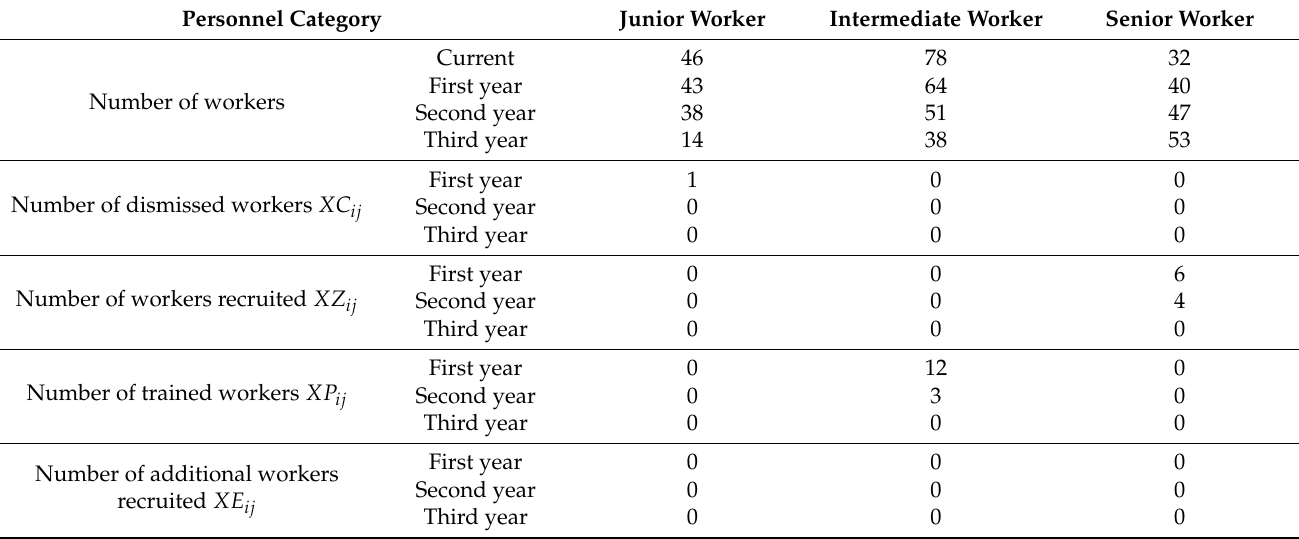
Table 11. Optimal allocation of worker mobility in the lowest cost model for the past three years.